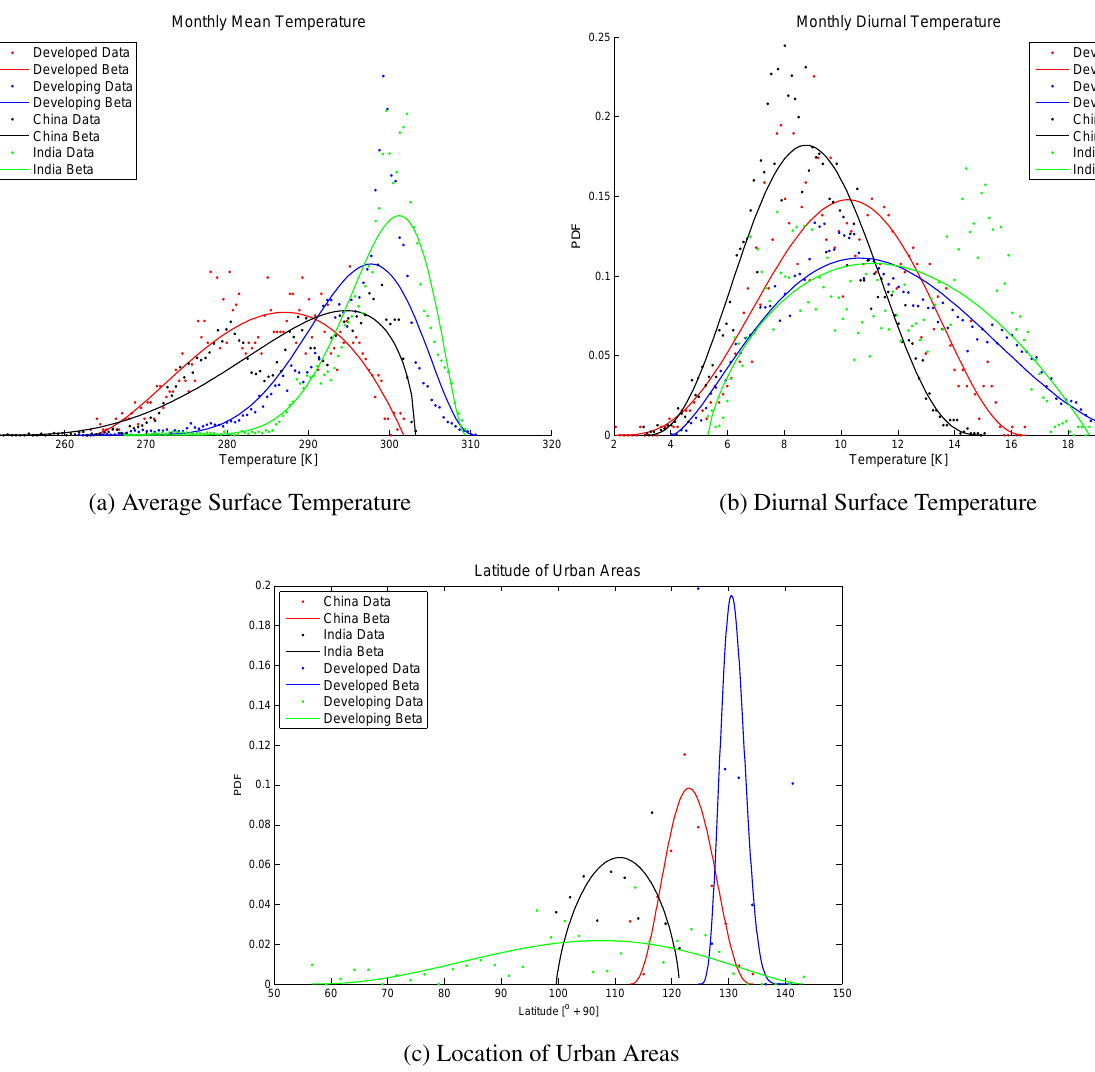
Fig. 2. PDFs of the number of degrees latitude North, from the South Pole, for the urban areas, where the dots are the fraction of urban areas in each latitude bin (urban area location data are from Center for International Earth Science Information Network, 2005); and the PDFs of the associated average daily surface temperature and the average daily diurnal temperature variation (daily high minus daily low) for each urban area, where the dots are the data for the monthly averaged respective values. In all cases, the lines represent the best beta function fits to the data.